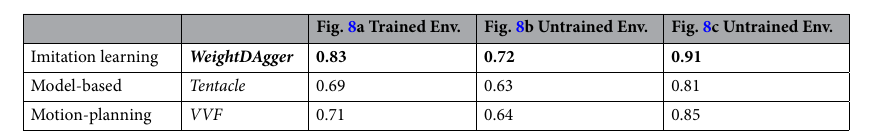
Table 3. Safe Distance Range Ratio. * Note . The values represent the average safe distance range ratio over five trials. Significant values are in bold.